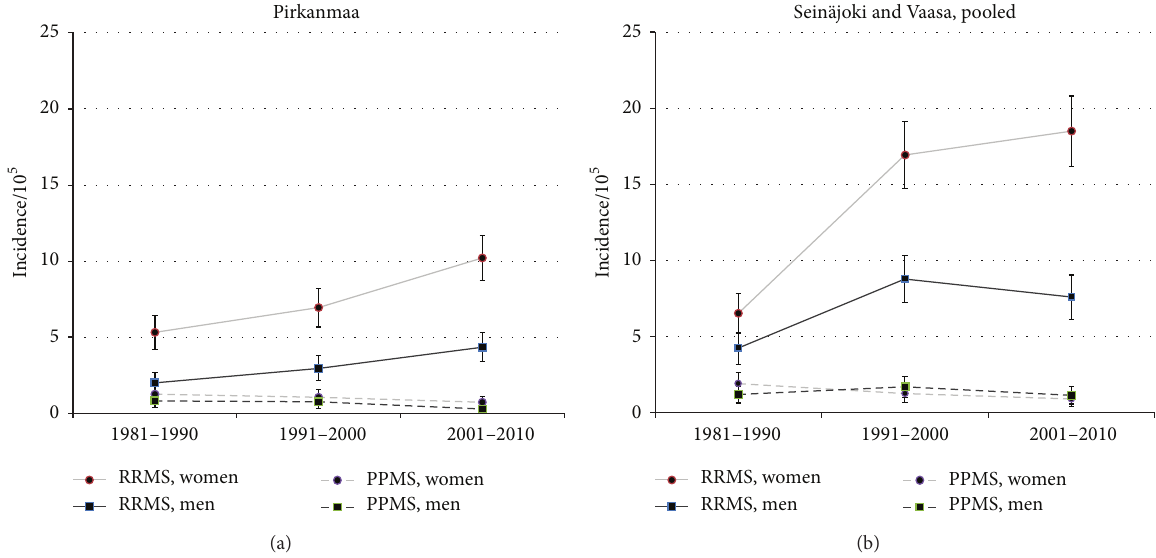
Figure 4: RRMS and PPMS incidence trends in medium-risk district Pirkanmaa (a) and high-risk districts Sein¨ajoki and Vaasa (b) from 1981 to 2010.